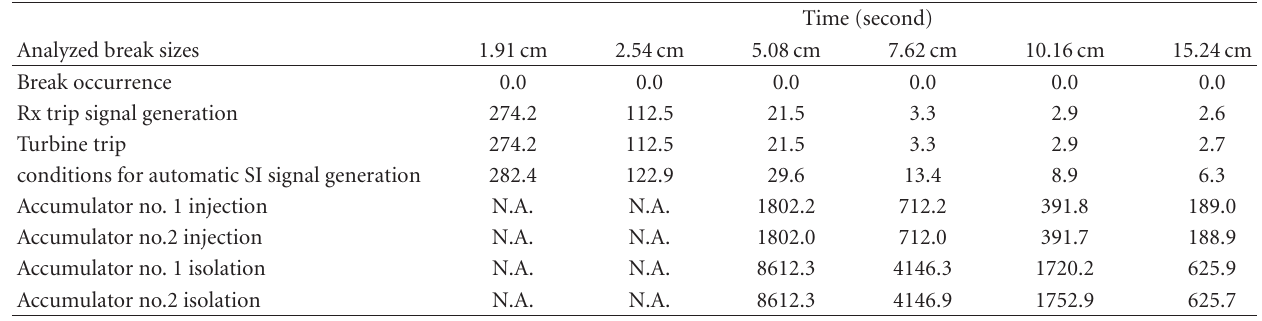
Table 5: Sequence of main events for LOCA calculations without SI signal.